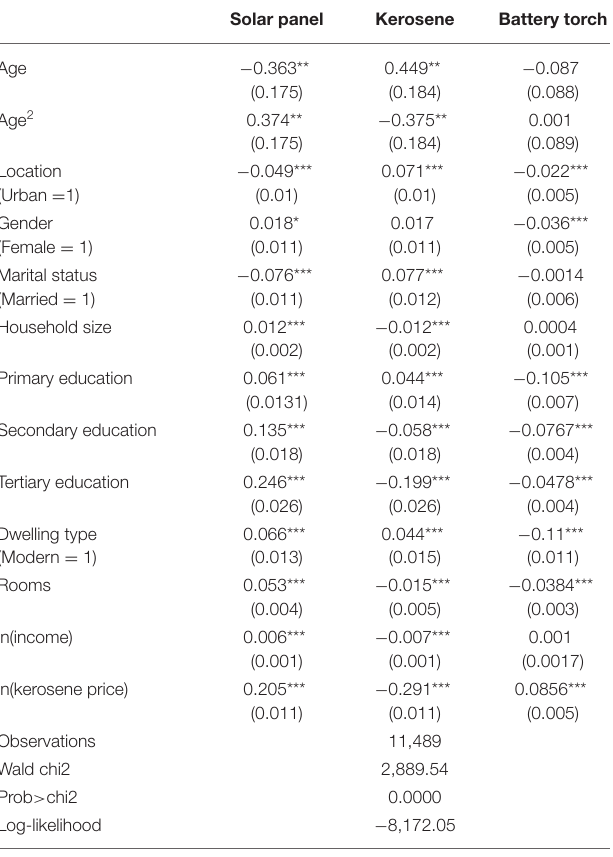
TABLE 6 | Average marginal effects of the alternative-specific multinomial probit model. Solar panel